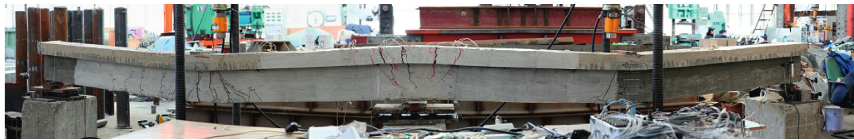
Figure 16: Two-span continuous composite T-shaped beams at failure.